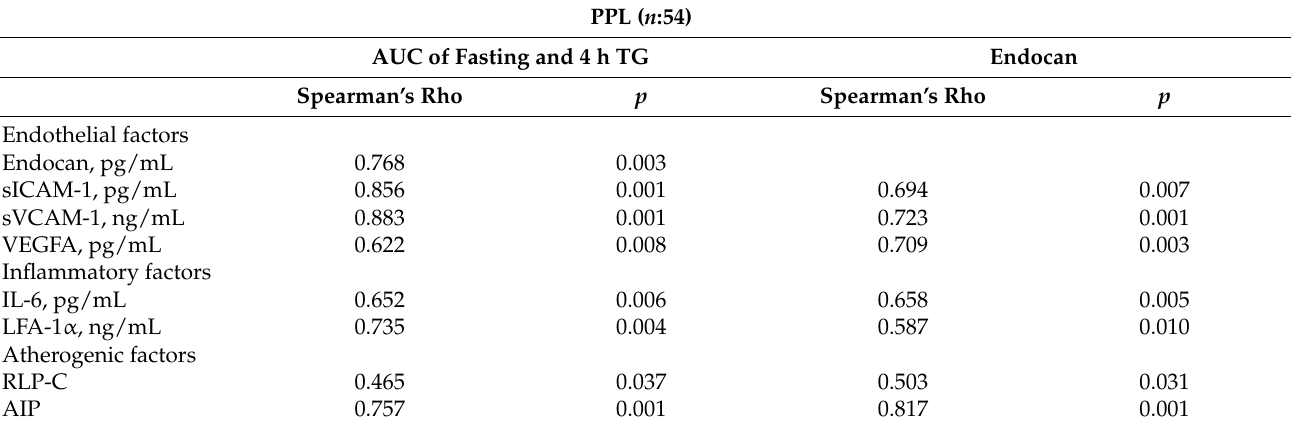
Table 3. Correlation coefficients of endothelial, inflammatory, and atherogenic factors with AUC and Endocan in PPL